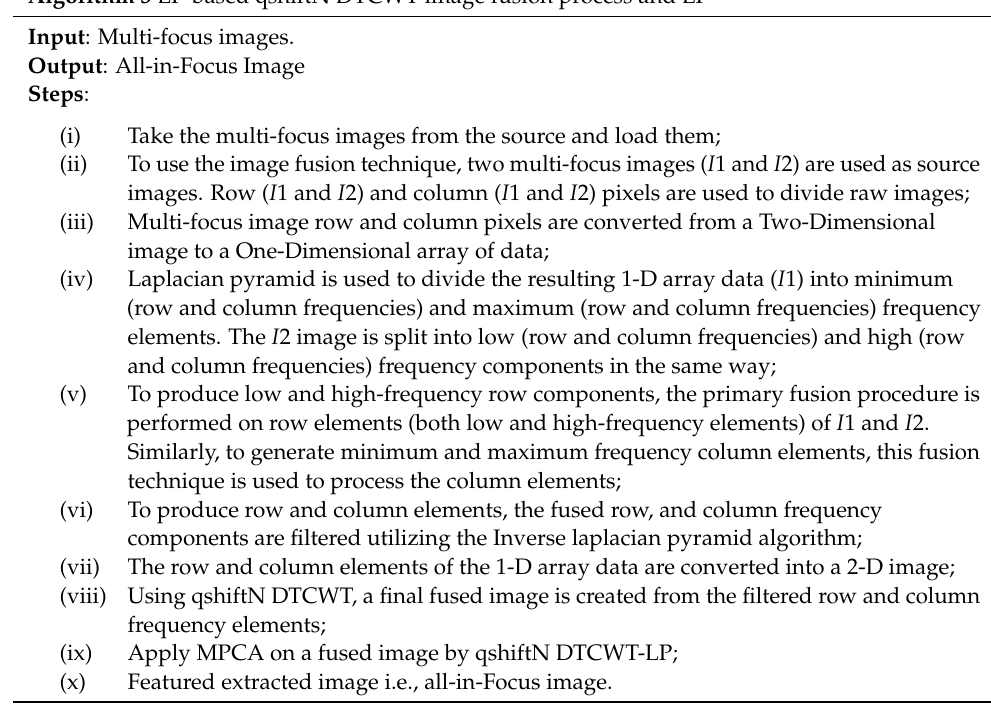
Algorithm 3 LP-based qshiftN DTCWT image fusion process and